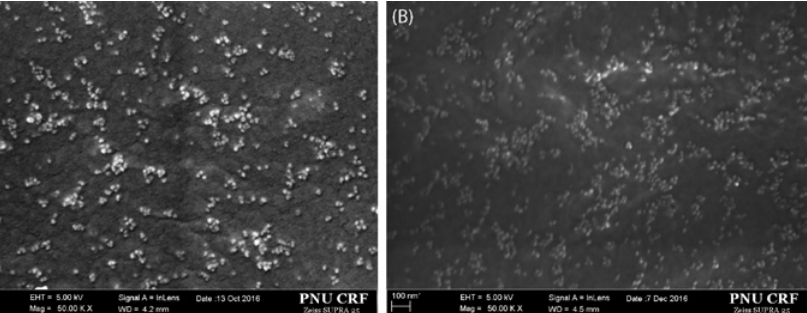
Figure 5: FESEM images of (A) 4sPMMA/(PMMA/CSP0) (HybM0) and (B) 4sPMMA/PMMA grafted MCSP3 (HybM3) hybrid nanocomposites.